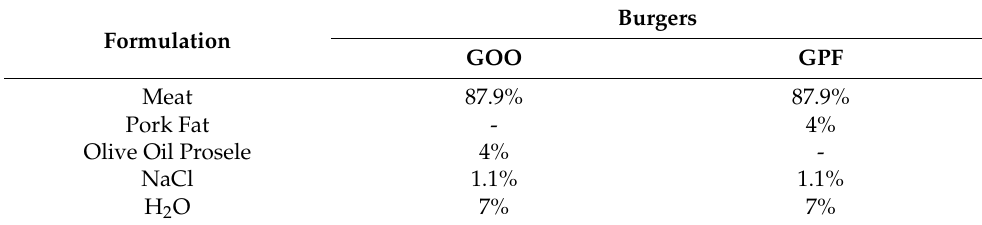
Table 1. Formulations of the two burgers